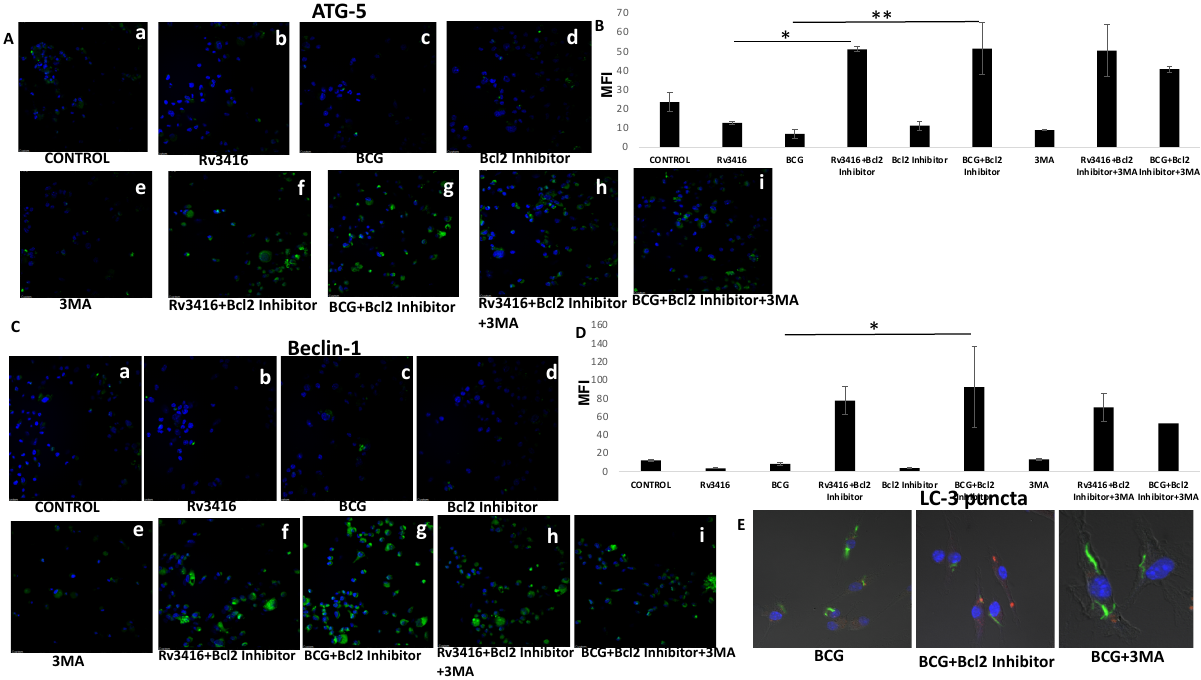
Figure 6: Inhibiting Bcl2 induces autophagy in Rv3416 stimulated BMDCs. For Panel A&C, BMDCs were incubated with 10 μM Bcl2 Inhibitor for 1h (Sub-Panels d,f,g,h&i) followed by stimulation with 15 μg/ml Rv3416 (Sub-Panels b,f&h) or infection with 2.5 MOI of BCG for 24h (Sub- Panels c,g&i). Sub-Panels e,h&i cells were treated with 10 μM 3-MA prior to stimulation with either Rv3416+Bcl2 Inhibitor (Sub-Panel h) or BCG+Bcl2 Inhibitor (Sub-Panel i). Cells were stained with biotinylated and FITC conjugated specific antibodies to ATG-5 (Panel A) or Beclin-1 (Panel C). For Panel E cells were incubated with 10 μM Bcl2 Inhibitor with or without 3-MA for 1h followed by infection with 2.5 MOI of GFP-BCG for 24h. Cells were stained with biotinylated and PE conjugated antibody to LC-3. Nucleus of the cells was stained with DAPI (blue). Confocal imaging was performed with Nikon C2 laser scan confocal microscope. Data were analyzed using the NIS Elements Advanced Research software. Data shows a representative image of two independent experiments. Bar charts in Panel B&D represent the mean Fluorescence Intensity of two independent experiments (of 5 fields/experiment) for each panel. For Panel A, P value between groups Rv3416 and Rv3416+ Bcl2 Inhibitor is P<0.05, between groups BCG and BCG+Bcl2 Inhibitor is P<0.01. One way ANOVA was performed followed by Bonferroni’s multiple comparison post-hoc test with 95% confidence interval for ATG-5. * denotes statistical significance at P<0.05. ** denotes statistical significance at